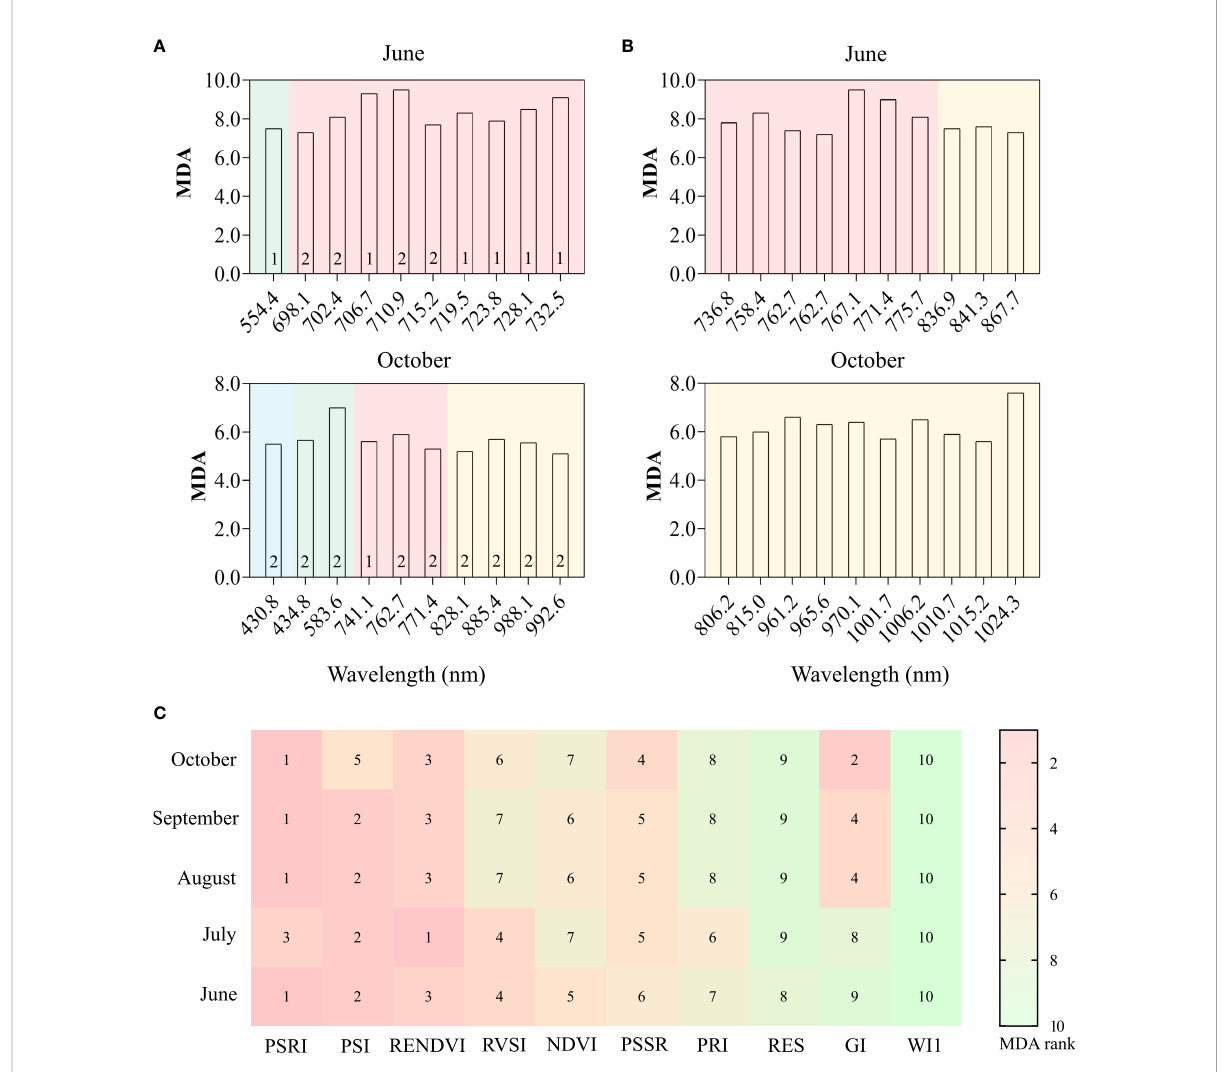
FIGURE 11 Mean Decrease Accuracy (MDA) of the top 10 variables ranking for all spectral features (A) , spectral wavelength (B) , and VIs (C) for separating the two groups of trees using the RF classi fi cation model. Numbers “ 1 ” and “ 2 ” in (A) indicate 1 st and 2 nd derivative, respectively. The different backgrounds in (A, B) indicate the band region: blue (blue), green (green), red edge (red), as well as NIR (yellow). The numbers in (C) represent the MDA rank of each